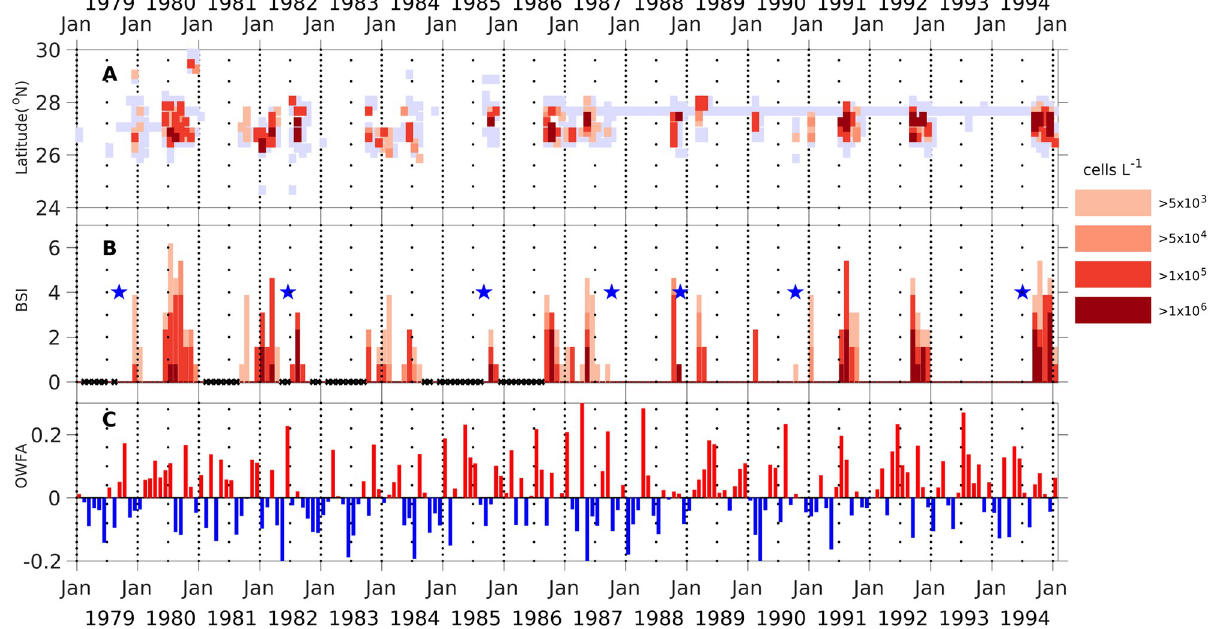
Fig 9. Comparison of binned monthly maximal bloom concentration and monthly severity with the monthly wind frequency anomalies for 1979– 1984. (A) Hovmo¨ller diagram for the maximal K. brevis cell counts in each 0.2˚ latitudinal bin for 25.4˚-28.4˚ N for each month (Fig 2). (B) Normalized monthly bloom severity index (BSI) for cell counts in 1979–1994, accumulated from (A). (C) Proportional onshore wind frequency anomaly (OWFA) during each month from the data-assimilative NARR (North American Regional Analysis) product for the location of the VENF1 station (Fig 1). More Positive values are marked in red (more frequent onshore wind) and negative values (less frequent onshore wind) are marked in blue. Markers for the years indicate January 1. In (A), white indicates no samples, light blue gray indicates < 5,000 cells L-1. In (B), Xs on the X-axis indicate no samples were collected (prior to 1987), and the blue stars indicate times when tropical storms had impacts on southwest Florida coastal waters.